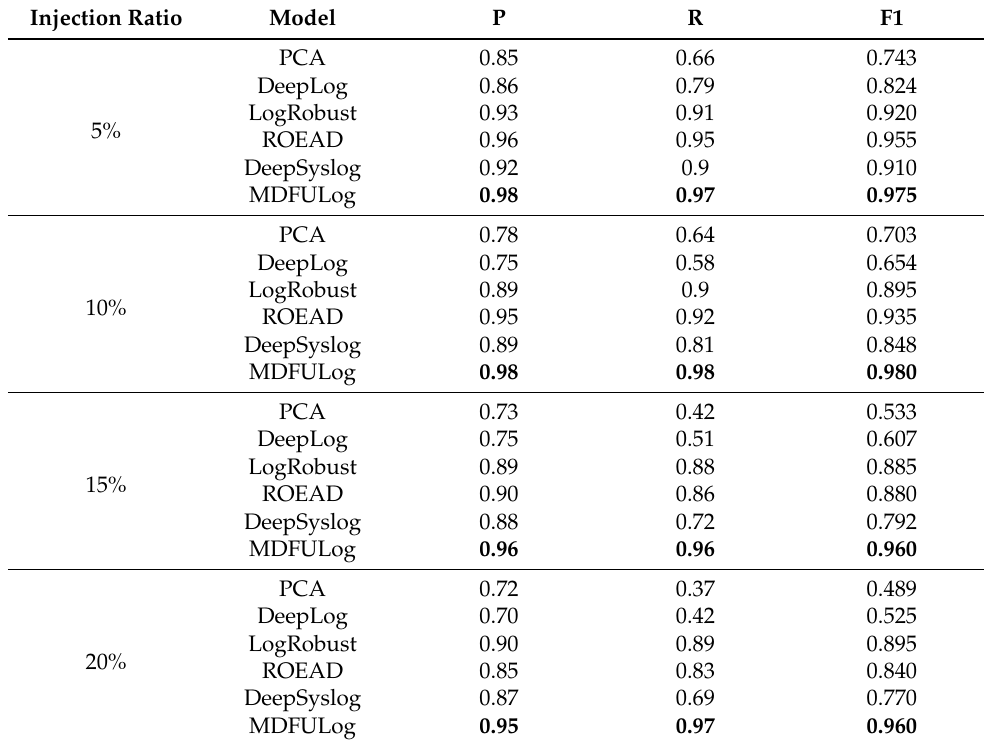
Table 2. Results for comparing MDFULog versus the baseline methods on unstable